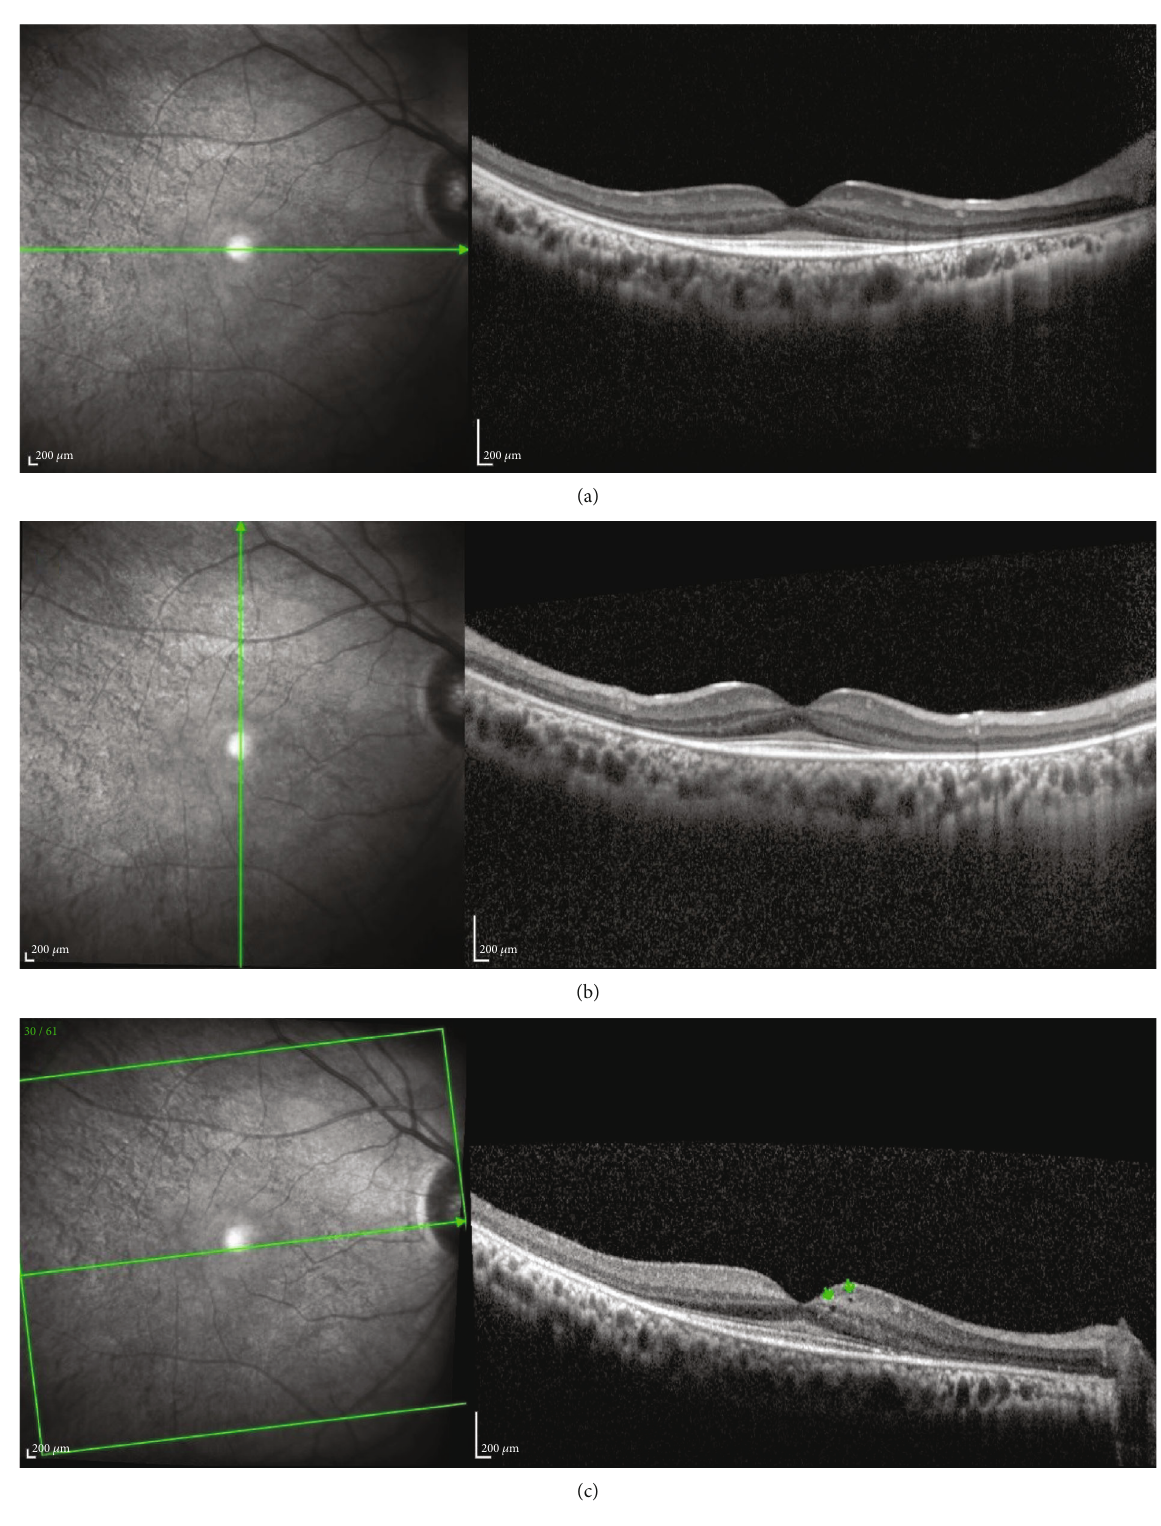
Figure 2: SD-OCT horizontal and vertical scans of fovea in the right eye (a, b). It demonstrates foveal increased thickness of hyperre fl ective band signal at the ELM, with intact myoid, ellipsoid, and interdigitation zones, RPE, and Bruch ’ s membrane. In the parafoveal and perifoveal region, it demonstrated a progressive loss of interdigitation and ellipsoid zones, myoid zone, and ELM and thinning of the outer nuclear layer. SD-OCT horizontal scan, close to the fovea (c), demonstrated a small cyst in ONL, INL, and GCL (arrows). SD-OCT: spectral domain optical coherence tomography; ELM: external limiting membrane; RPE: retinal pigment epithelium; ONL: outer nuclear layer; INL: inner nuclear layer; GCL: ganglion cell